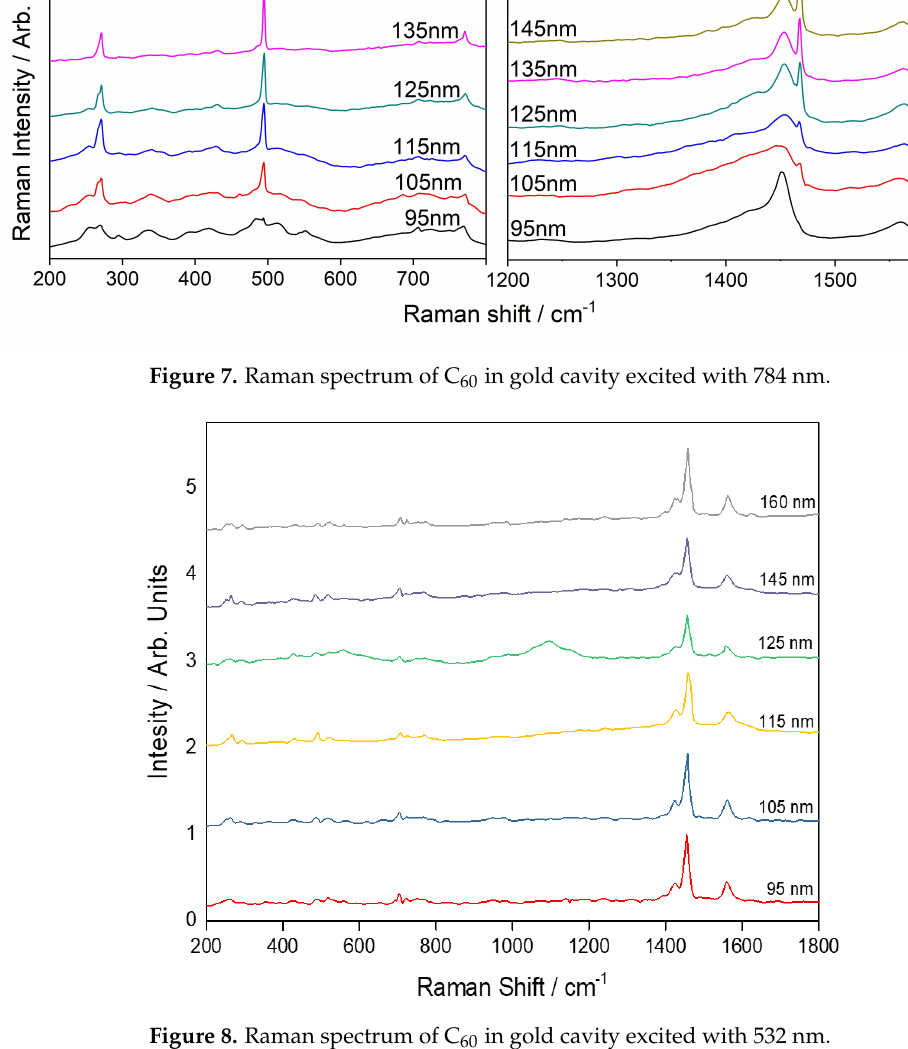
Figure 8. Raman spectrum of C 60 in gold cavity excited with 532 nm.